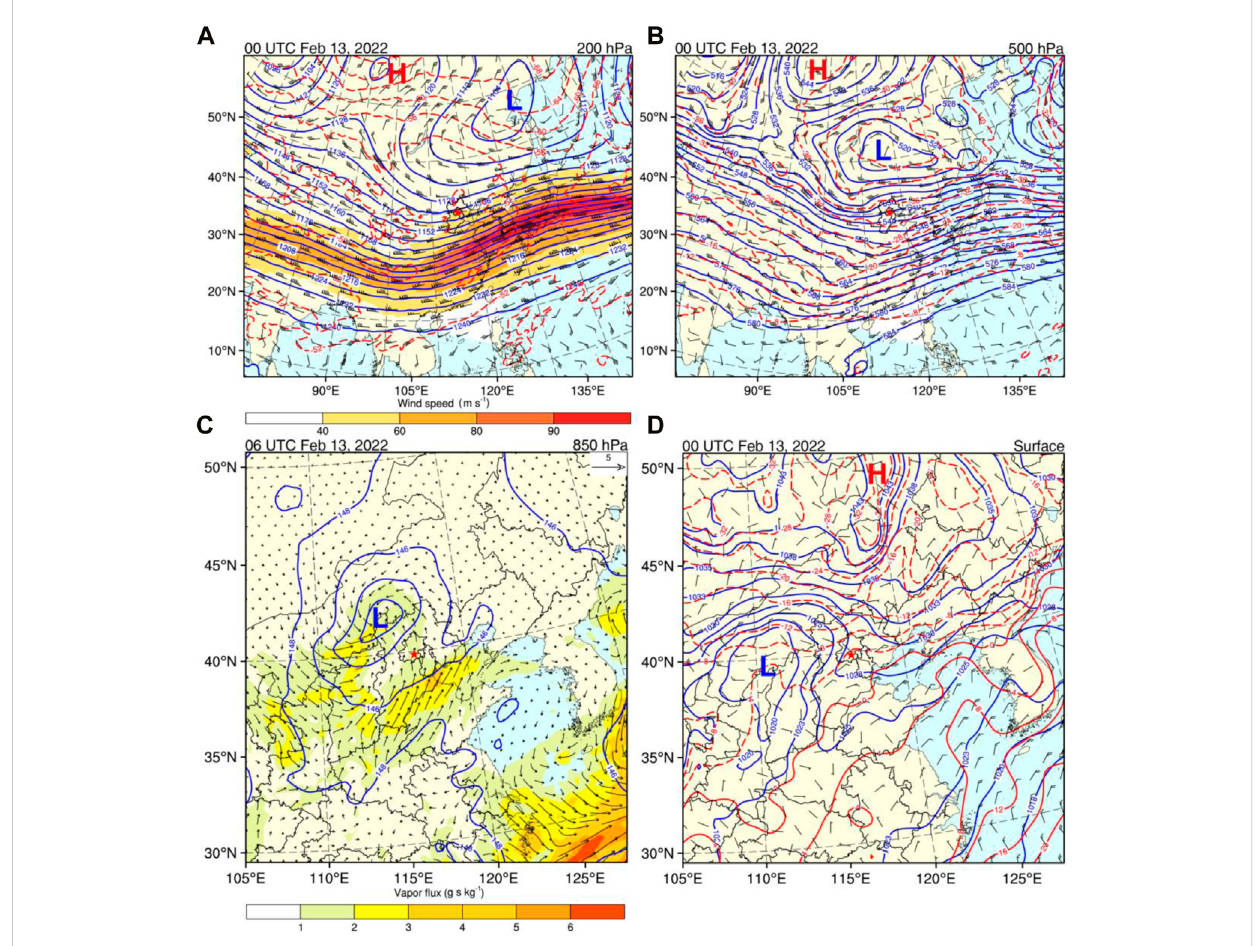
Synoptic-scale atmospheric circulation fi elds on February 13, 2022. (A) Upper-level jet (shading; unit: m s − 1 ), geopotential height (blue contours; unit: dagpm), temperature (red contours; unit: ° C), and wind fi eld (barb symbols) at 200 hPa for 0000 UTC. (B) Geopotential height (blue contours; unit: dagpm), temperature (red contours; unit: ° C), and wind fi eld (barbs) at 500 hPa for 0000 UTC. (C) Geopotential height (blue contours; unit: dagpm) and water vapor fl ux (shading and vector arrows; unit: g s kg − 1 ) at 850 hPa for 0600 UTC. (D) Sea level pressure (blue contours; unit: hPa), temperature (red contours; unit: ° C), and wind fi eld (barb symbols) at the surface for 0000 UTC. Red asterisk indicates the location of the Beijing station (No.: 54,511). Half and full wind barb symbols denote 2 and 4 m s − 1 ,